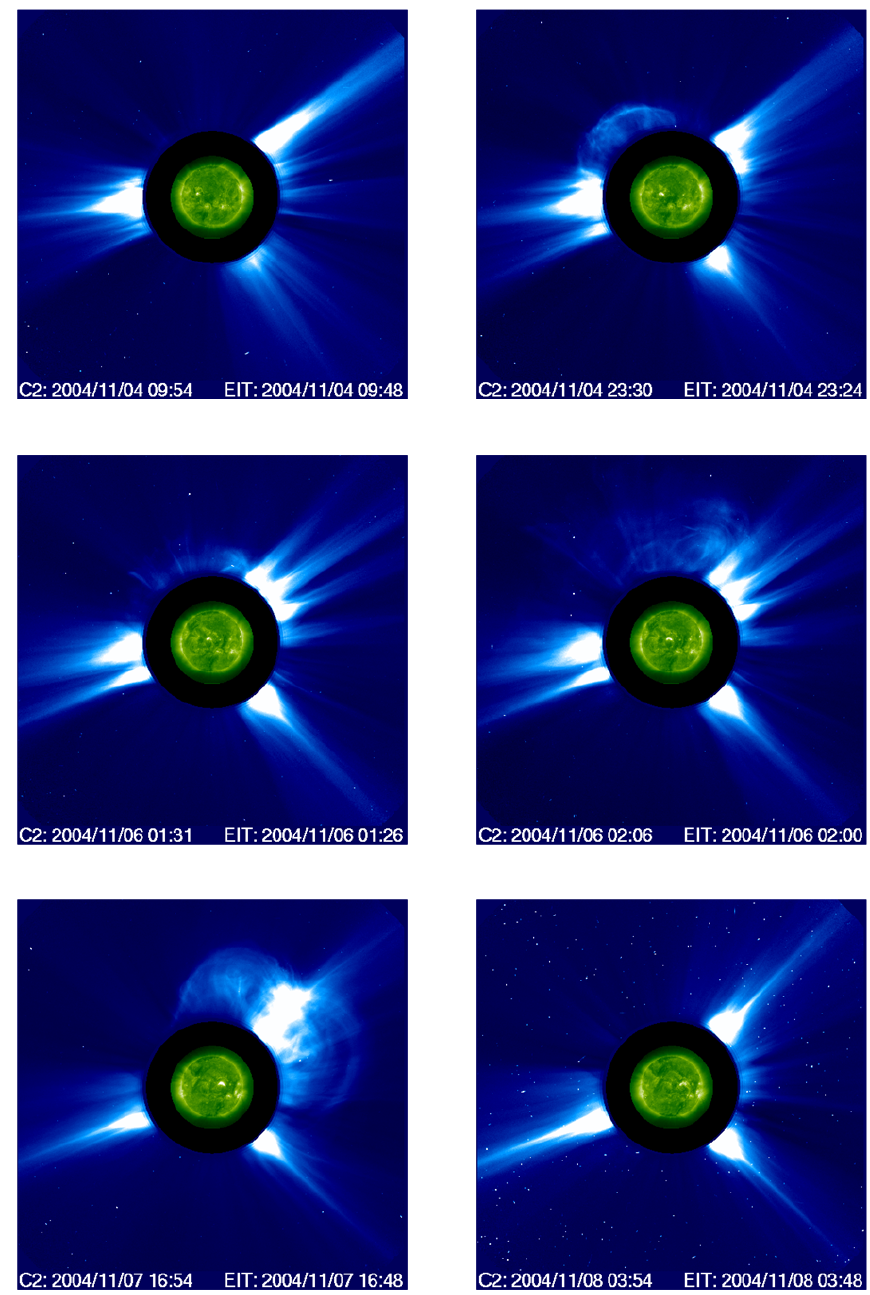
Fig. 1. Figure showing six composite images taken by the SOHO | LASCO C2 and SOHO | EIT instruments. The earlier five images are related to the events discussed here as summarised in Table 1. The sixth image (bottom right) is likely not related to the geomagnetic storms at the Earth (as described in the text) but may be visible in the reconstructed images (see later figures and respective explanations in the text). Images were taken from the Coordinated Data Analysis Workshop (CDAW) database (http://cdaw.gsfc.nasa.gov/CME list/) on the World Wide